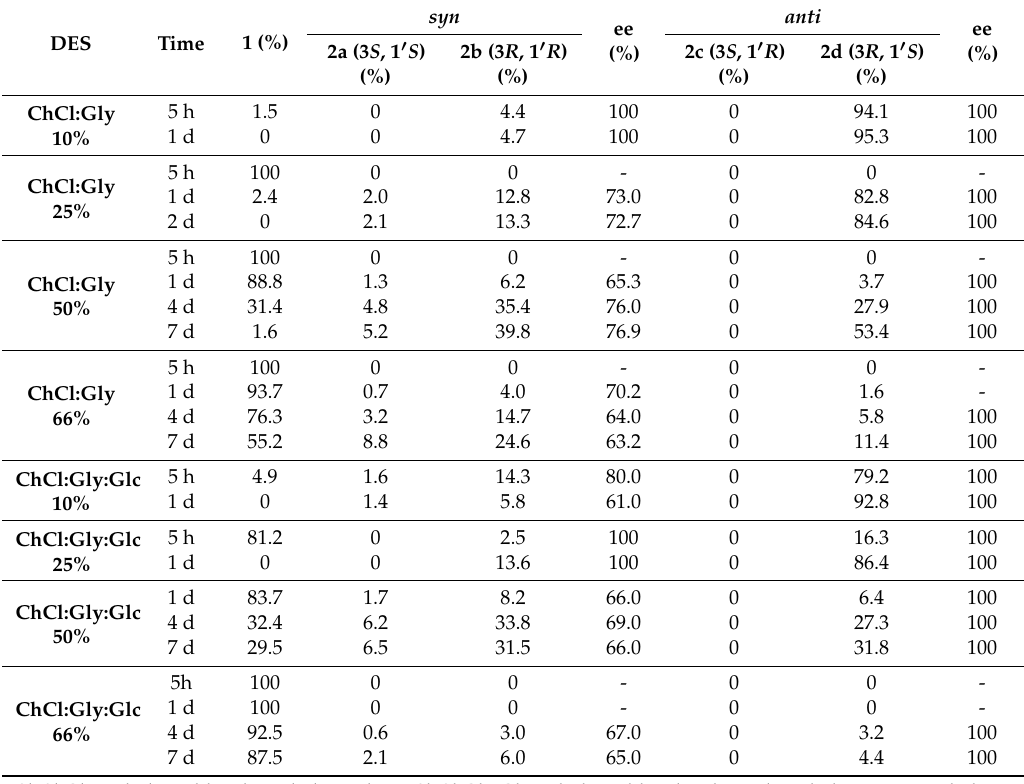
Table 8. The results of biotransformation of α -acetylbutyrolactone 1 by R. marina AM77 in resting cells culture in the presence of different deep eutectic solvents (DES) (in % according to GC (chiral